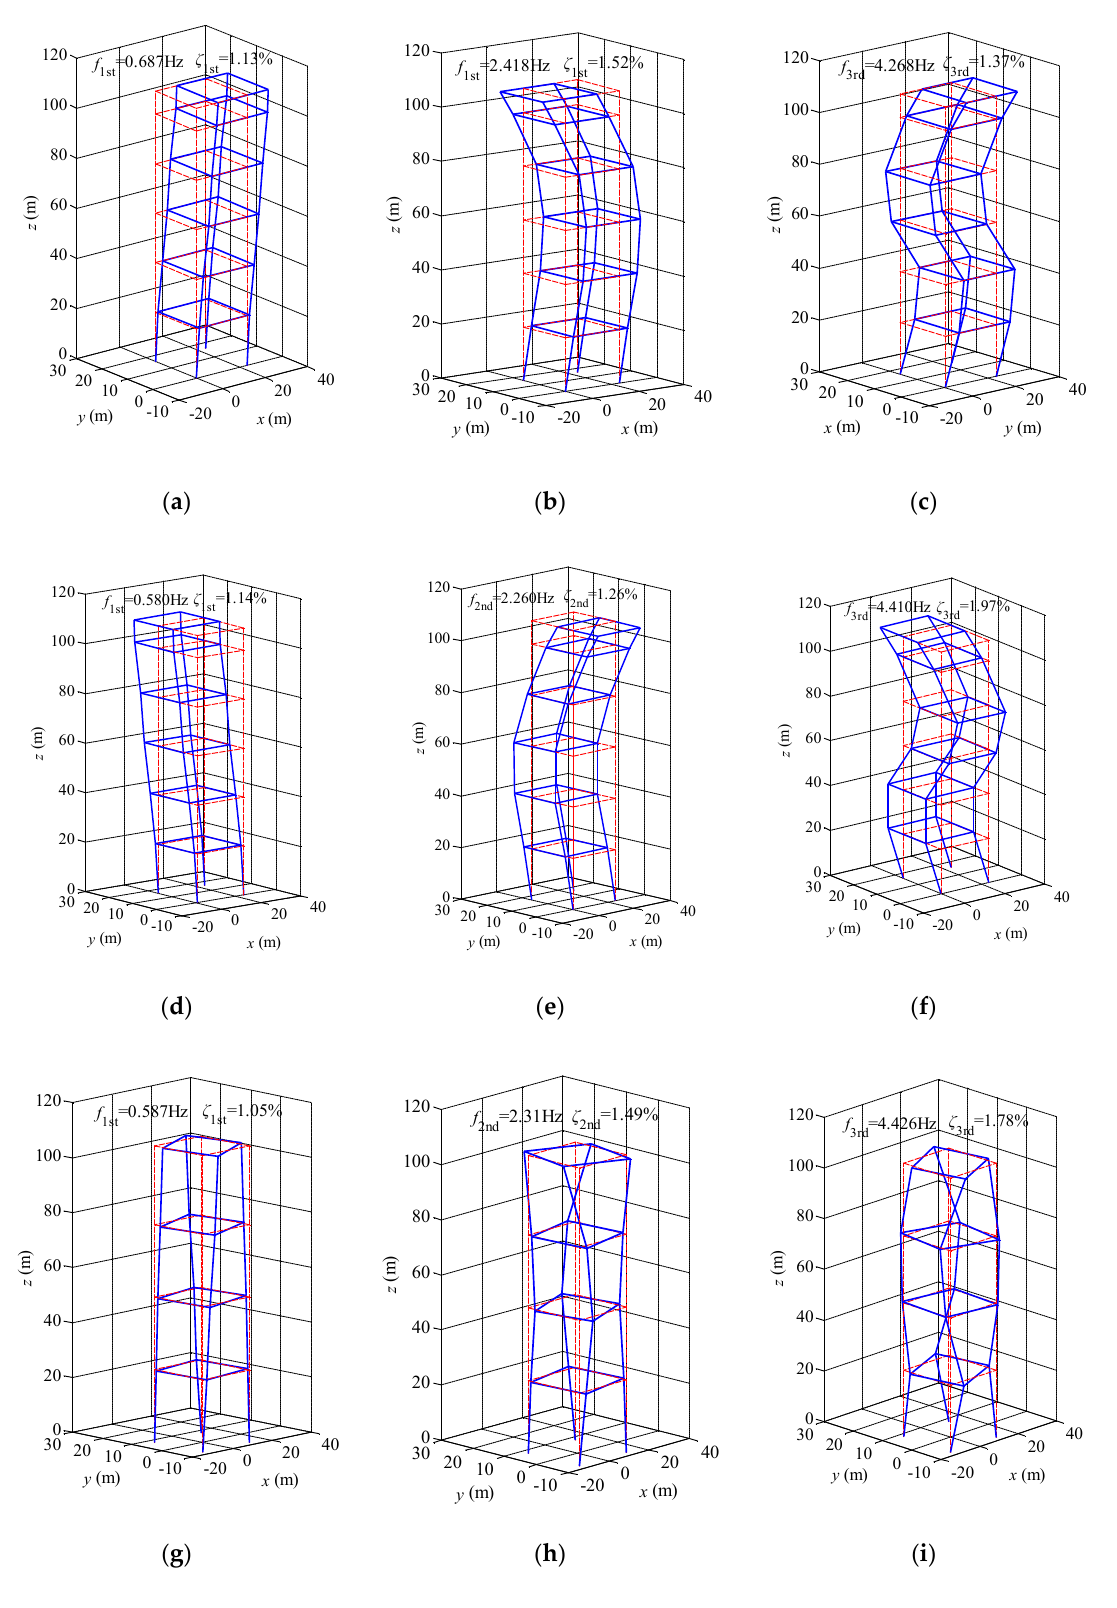
Figure 15. The first three modal parameters under ambient excitations identified by ERA-NExT. ( a ) 1st mode along x -axis; ( b ) 2nd mode along x -axis; ( c ) 3rd mode along x -axis; ( d ) 1st mode along y -axis; ( e ) 2nd mode along y -axis; ( f ) 3rd mode along y -axis; ( g ) 1st mode along torsional direction; ( h ) 2nd mode along torsional direction; ( i ) 3rd mode along torsional direction.